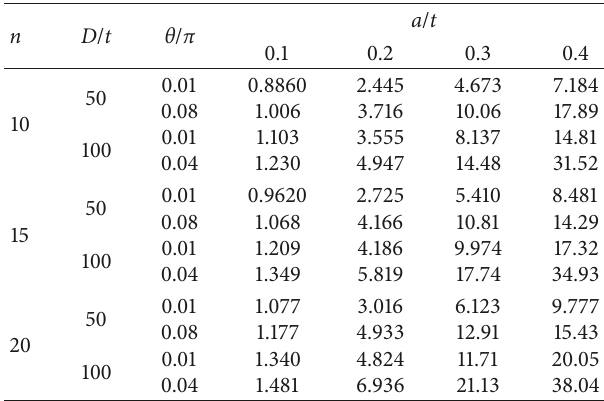
1 for thin-walled pipes under